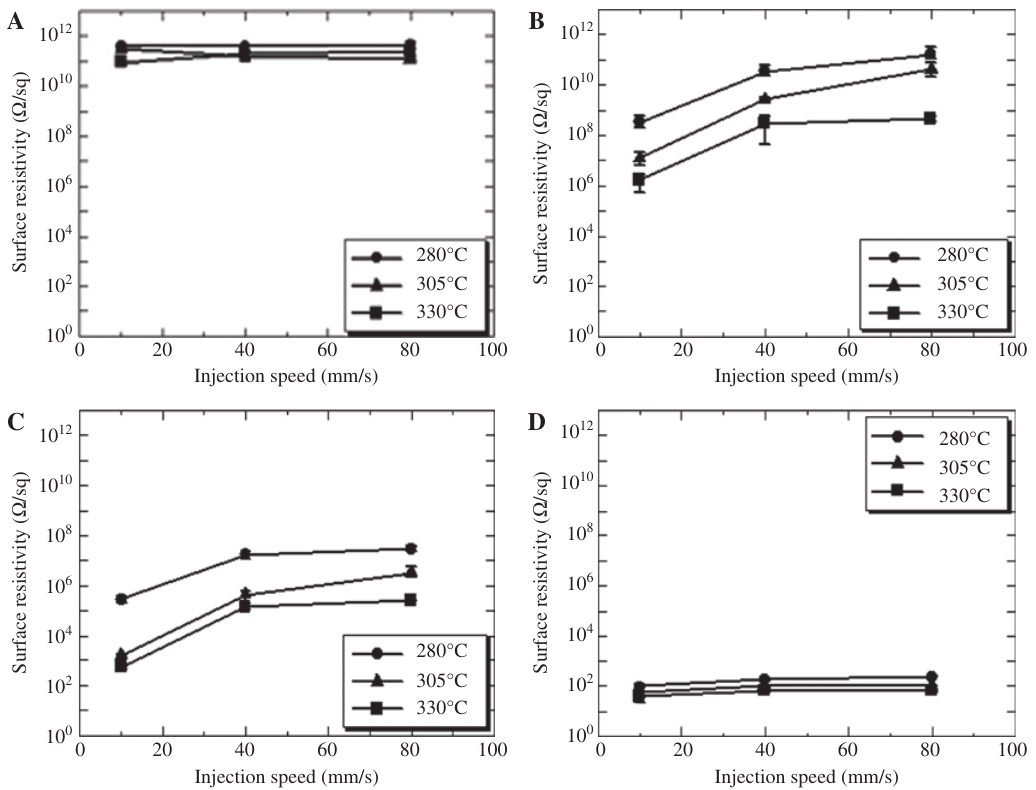
Figure 7: Effect of injection speed on surface resistivity of the MWCNT/PC composites with (A) 1 wt.% MWCNTs, (B) 2.5 wt.% MWCNTs, (C) 5 wt.% MWCNTs, and (D) 10 wt.%